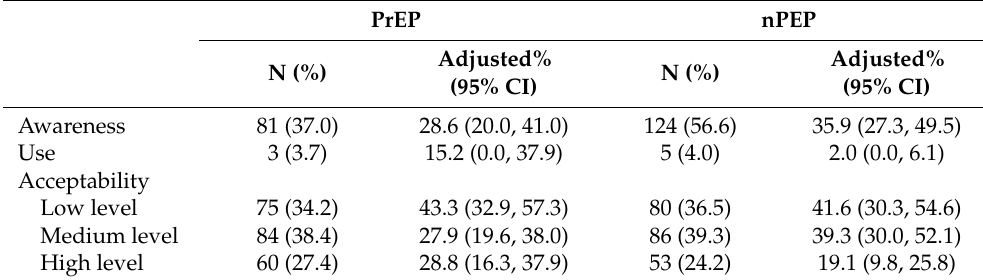
Table 2. Crude and adjusted awareness, use, and acceptability of PrEP and nPEP.